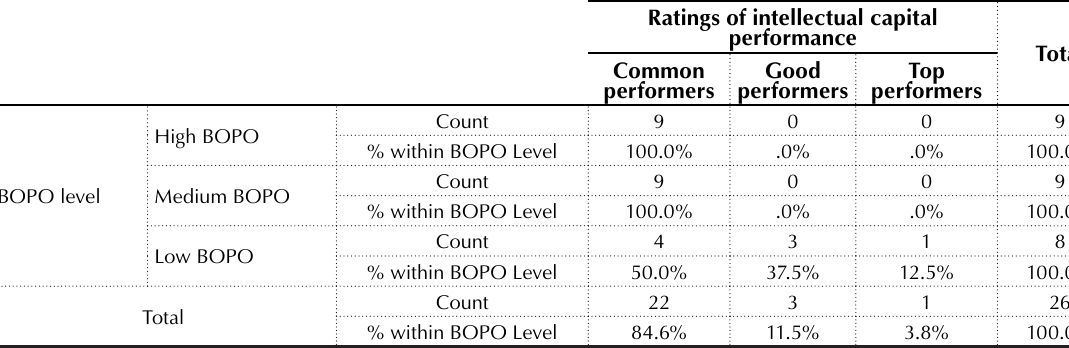
Source: Indonesia Banking Statistics of December 2014